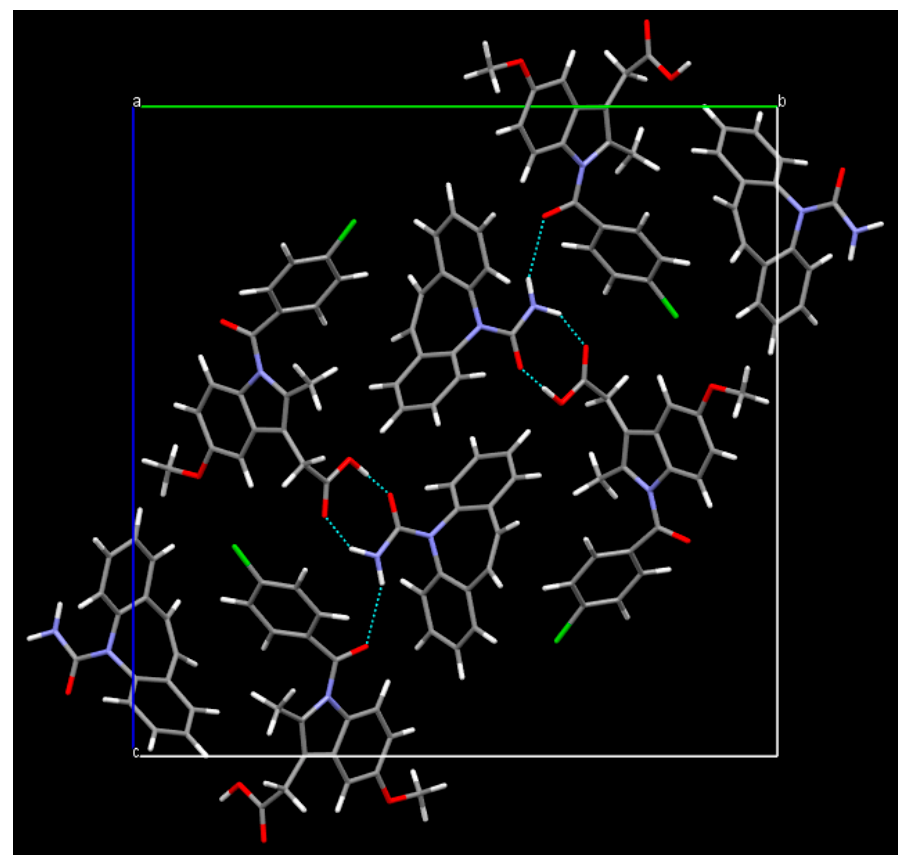
Table 4. Distances of atoms Cl1 and C9 to the mean plane of the C10–C11–C12–C13–C14–C15 benzene ring for the final CBZ:IND structure reported here and the INDMET03 structure.